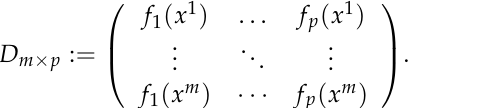
Table 3. Normalization techniques. Normalization Method Condition of Use Formula Linear normalization sum-based method Minimization criteria n Linear normalization sum-based method Maximization criteria n ij : = r ij (cid:115) Vector normalization Minimization criteria n ij : = 1 − Vector normalization Maximization